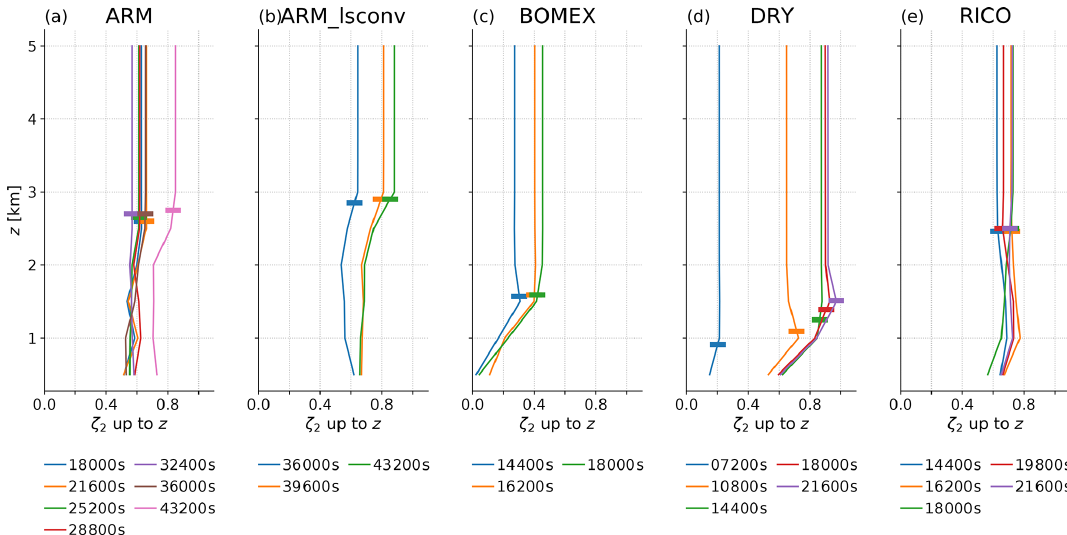
Figure 4. Calculated structure function exponents using separation distance 0.5–1km directly on LES output, calculated for integrated water vapour up to each labelled capping altitude, every 0.5km. The PBL top derived from the location of the maximum vertical gradient in potential temperature is shown as a horizontal bar for each profile.